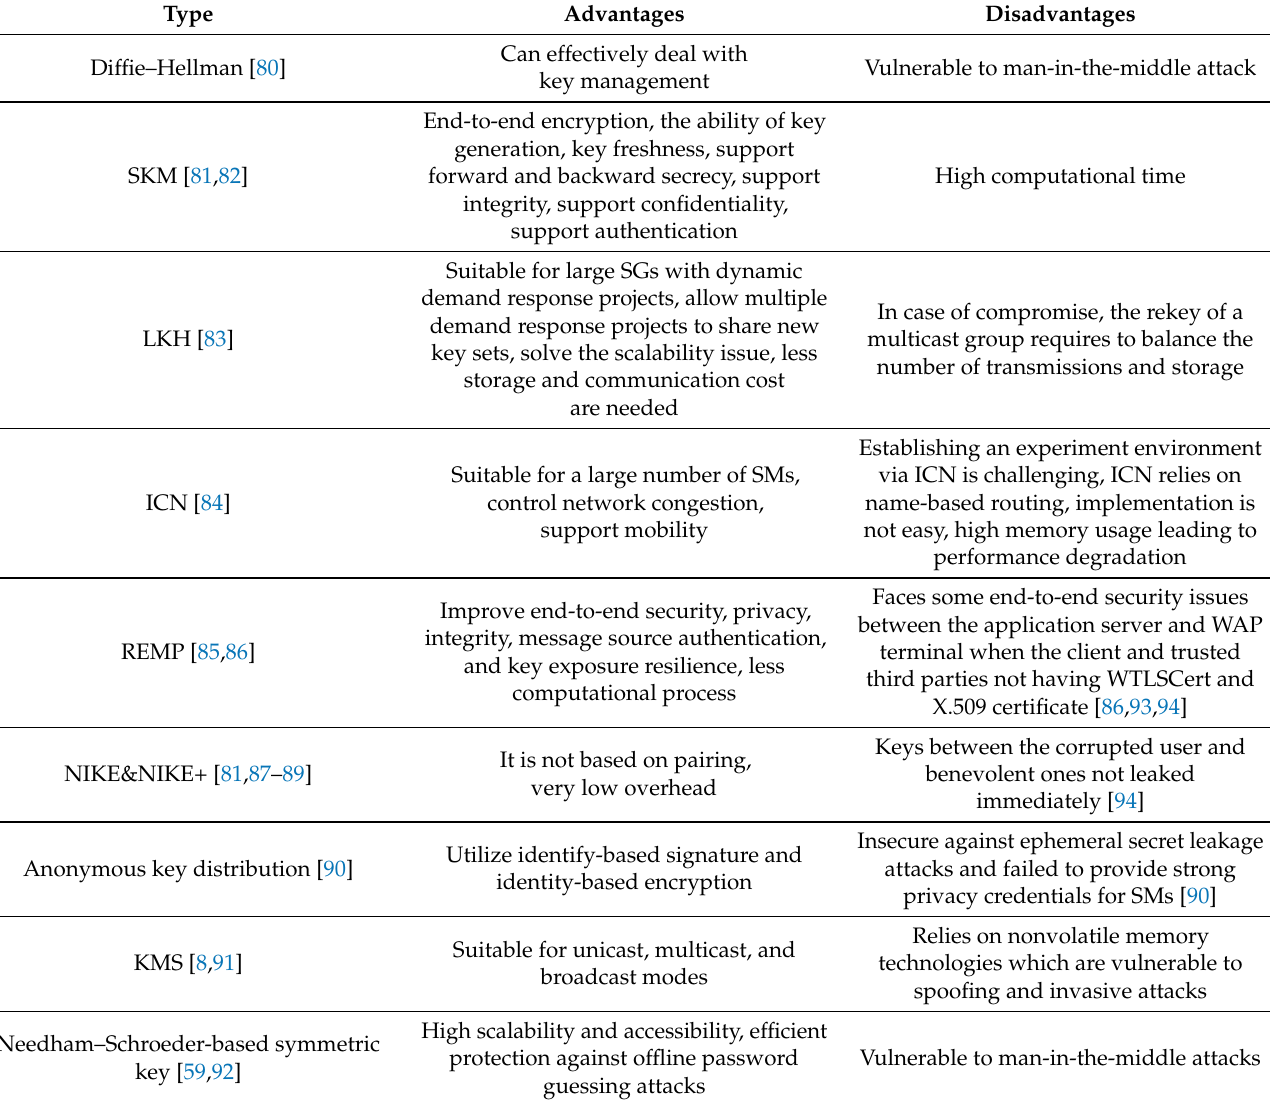
Table 1. Common types of key-management